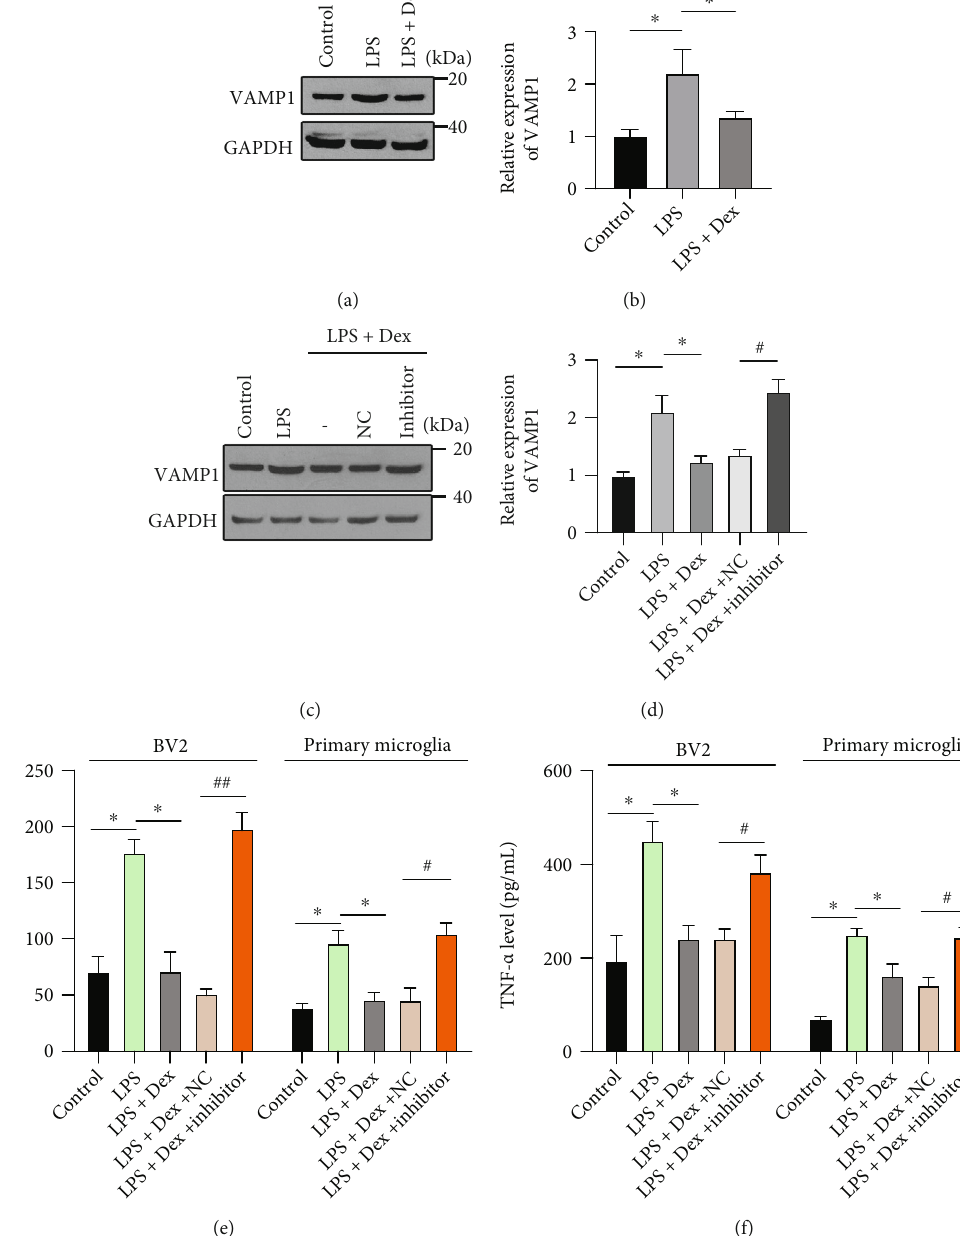
Figure 4: Dexmedetomidine alleviates LPS-induced microglial activation in vitro . ((a) and (b)) BV-2 cells were treated with LPS with or without dexmedetomidine (Dex, 1 μ M), and cell lysates were then immunoblotted for VAMP1. ((c) and (d)) BV-2 cells were transfected with miR-103a-3p inhibitor or control, and treated with LPS with or without dexmedetomidine; the VAMP1 expression level was then determined. BV-2 cells or primary microglial cells were treated as in ((c) and (d)), and expression levels of IL-1 β (e) and TNF- α (f) were then determined by ELISA (DMSO as control, n =3, number of repeated experiments). Two tailed t -test, ∗ , # p < 0 : 05 , ∗∗ , ## p < 0 : 01